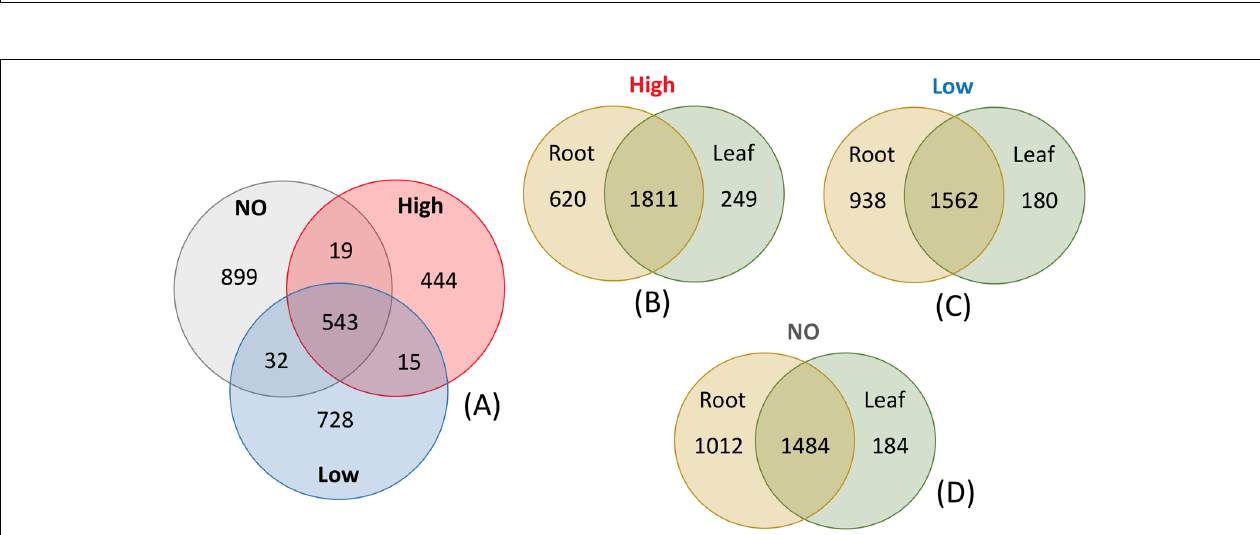
Frontiers in Plant Science |